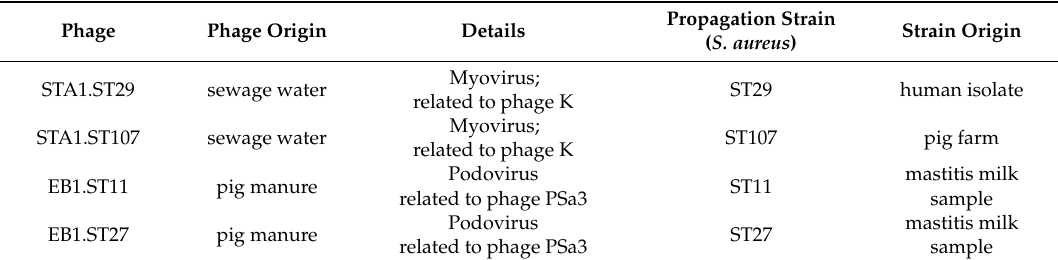
Table 2. Bacteriophages and propagation